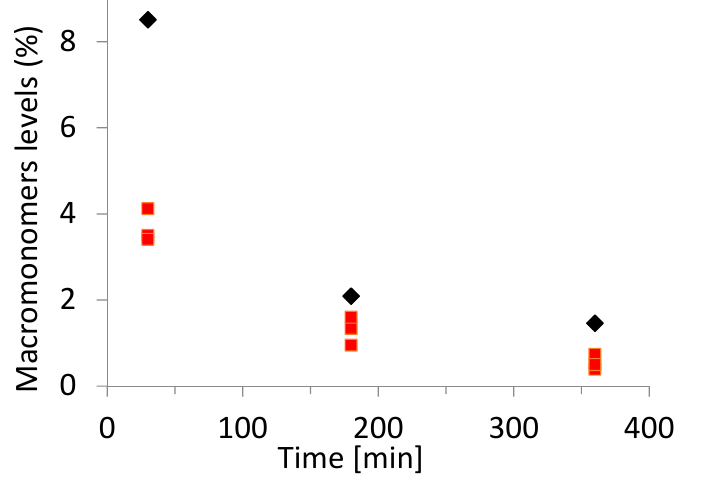
Figure 5. Macromonomer content (per 100 acrylate repeat units) determined by 1 H NMR, measured in polymer samples taken during semi-batch polymerization of BA ( ♦ ) and BA/HEA ( ■ ) in BPi at 138 ° C.